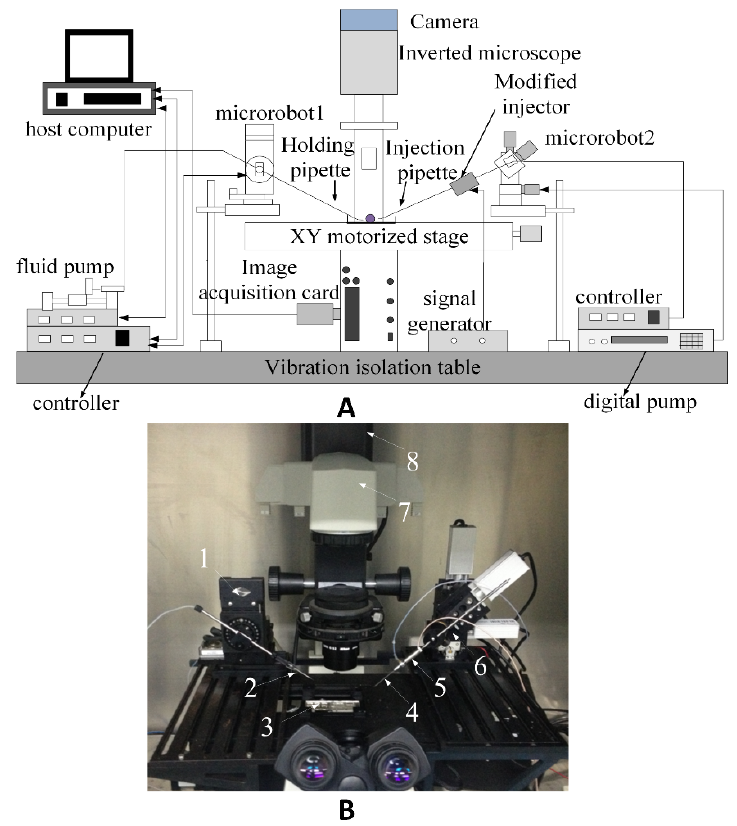
Figure 1. Mouse oocytes injection system. ( A ) Schematic diagram of the injection system architecture. ( B ) Part of the injection system: 1 is the microrobot-1, which is a three-degrees-of-freedom micromanipulator with a travel distance of 25 mm and a positioning accuracy of 0.04 µ m along each axis; 2 is the holding pipette which is used to immobilize the oocytes; 3 is the medium for placing the oocytes; 4 is the injection pipette for cellular piercing; 5 is the injector for cellular piercing; 6 is the microrobot-2, which is a three-degrees-of-freedom micromanipulator with a stroke of 20 mm and a step resolution of 0.04 µ m along each axis; 7 is the microscope; 8 is the Charged Coupled Device (CCD). Visual feedback is gained by the microscope and CCD.